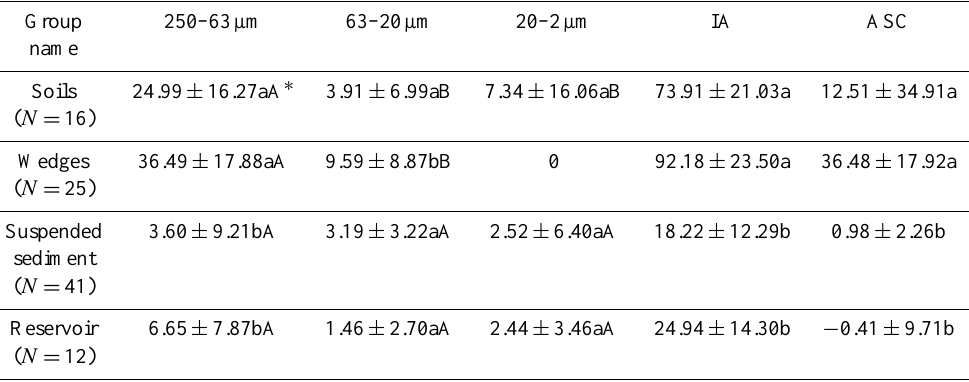
Table 2. Percentages of microaggregated particles in different size classes and microaggregation indices (IA, Wang et al., 2010; ASC, Igwe,